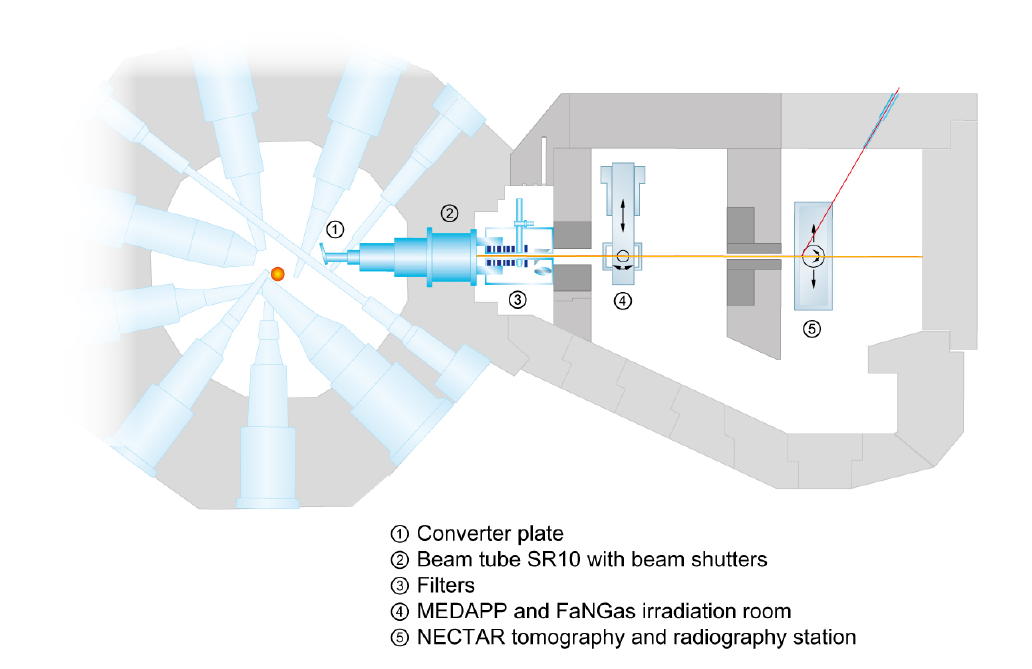
Figure 2: Schematic drawing of the facilities MEDAPP and NECTAR (Heinz Maier-Leibnitz Zentrum, 2015) at beam tube